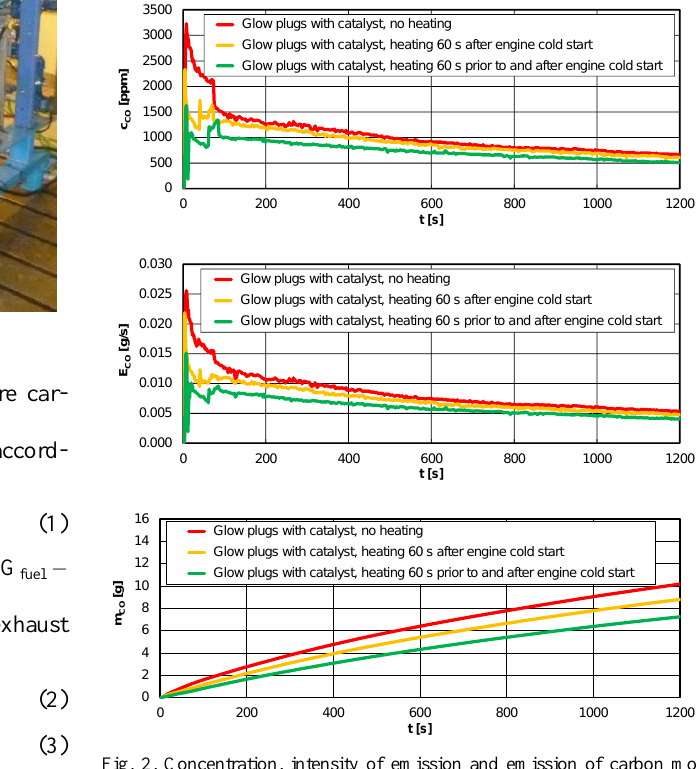
Fig. 2. Concentration, intensity of emission and emission of carbon mo- noxide during the tests performed on a diesel engine depending on the catalyst-coated glow plug heating time